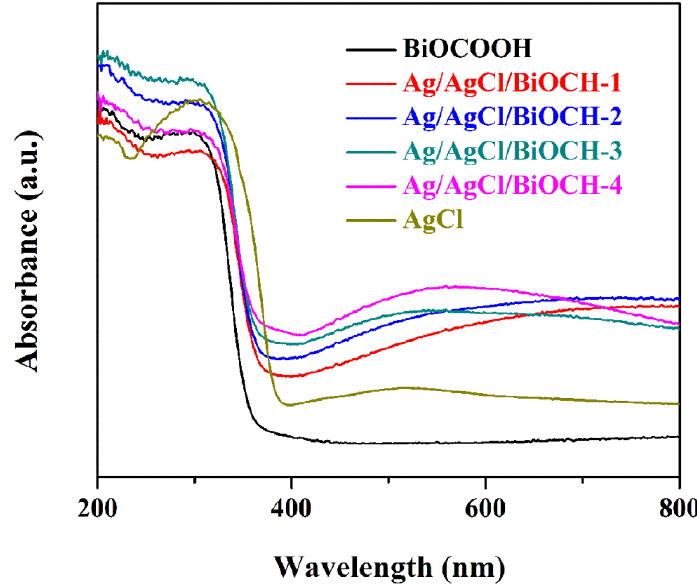
Figure4. UV-vis DRS of BiOCOOH, AgCl, and Ag / AgCl / BiOCOOH heterojunctions (Ag / AgCl / BiOCH-1, Figure 4. UV‒ vis DRS of BiOCOOH, AgCl, and Ag/AgCl/BiOCOOH heterojunctions Ag / AgCl / BiOCH-2, Ag / AgCl / BiOCH-3, and Ag / AgCl / (Ag/AgCl/BiOCH-1, Ag/AgCl/BiOCH-2, Ag/AgCl/BiOCH-3, and Ag/AgCl/BiOCH-4).